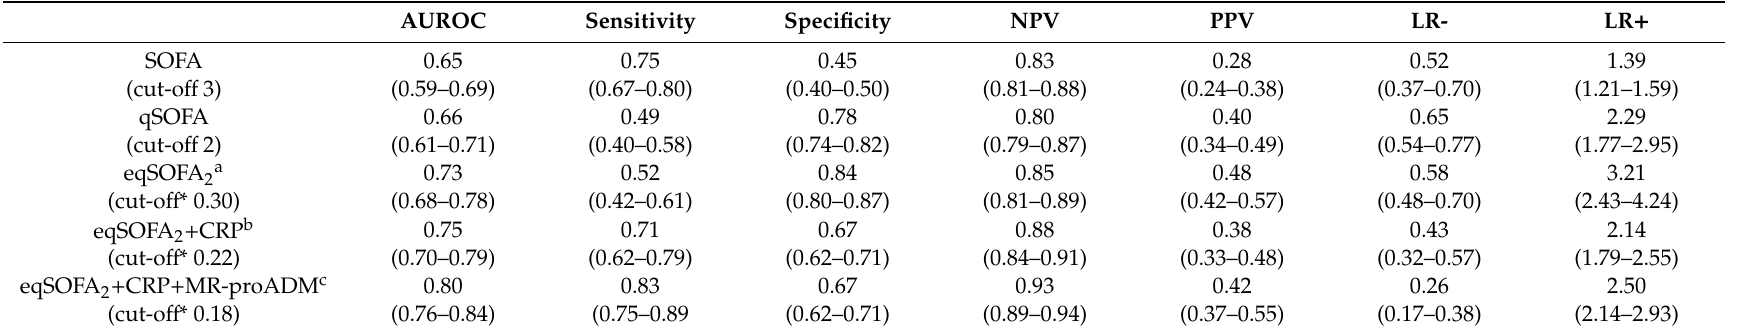
Table 4. Group 2: performance of the quick sepsis-related organ failure assessment (qSOFA), Model 4, Model 5, and Model